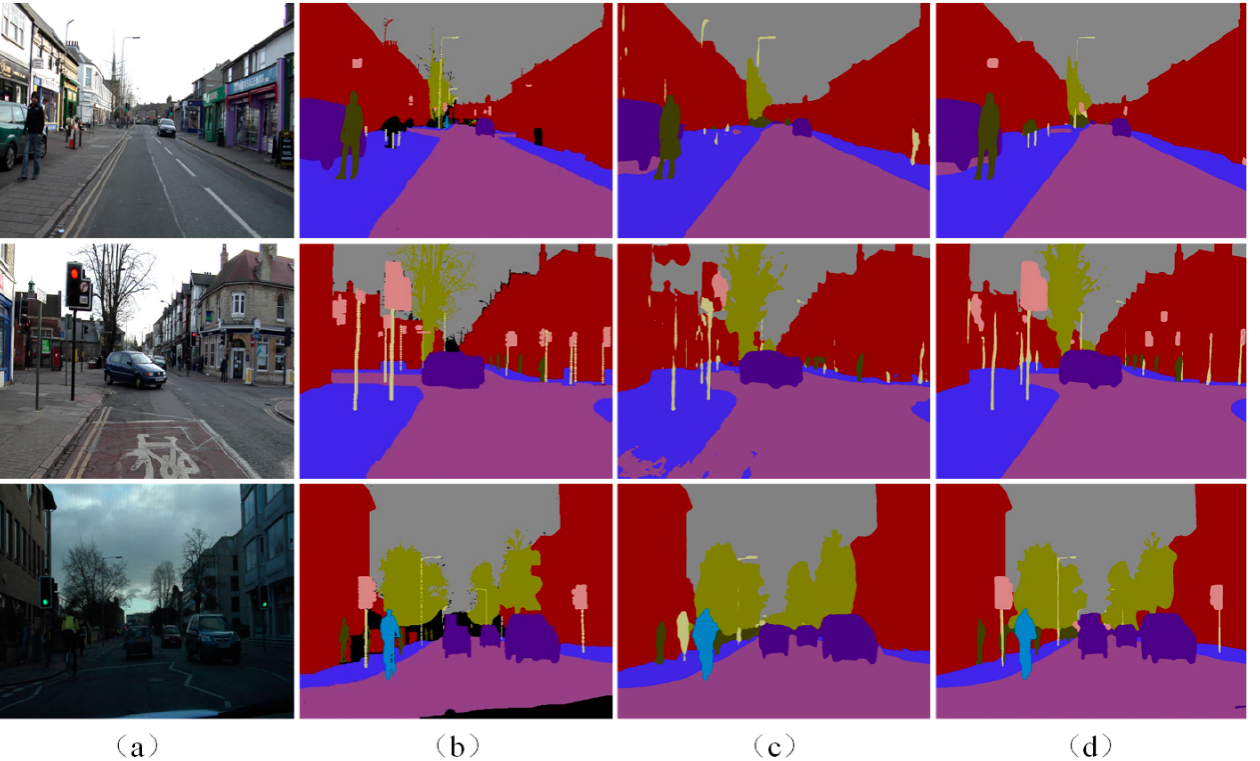
Figure 5. The visualization of the results of APMNet and the baseline with the CamVid dataset: ( a ) Inputs; ( b ) Ground Truth; ( c ) BiSeNet results; ( d ) APMNet results.